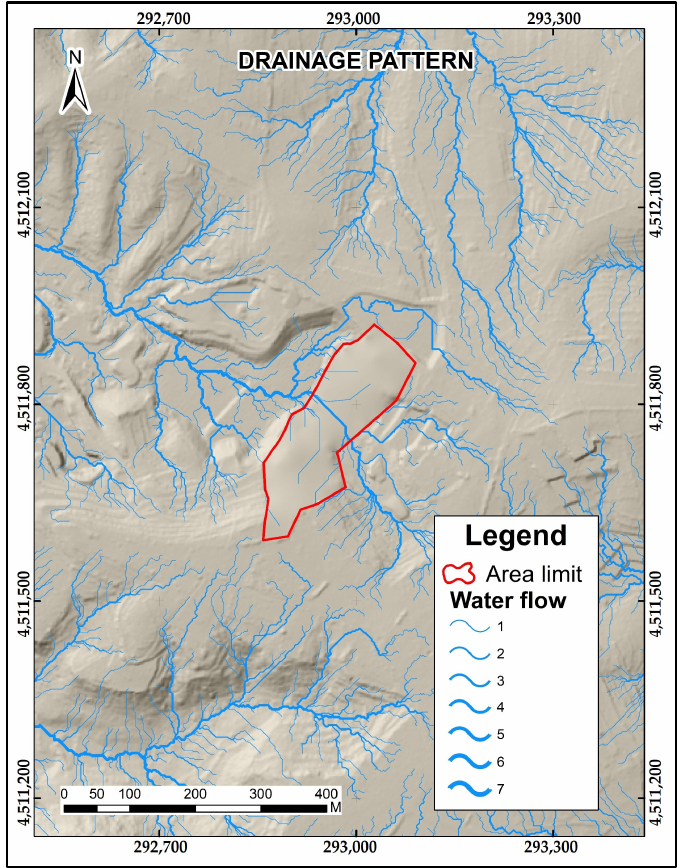
Figure 8. Drainage pattern integrated into the